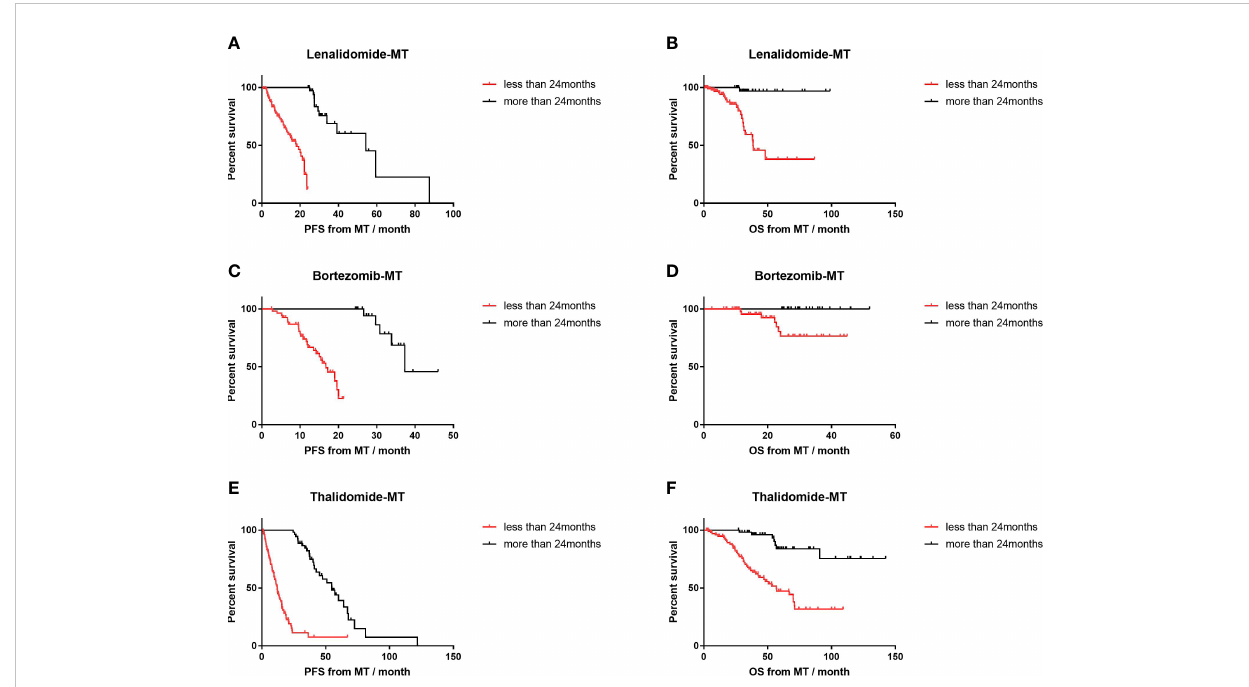
FIGURE 5 Impact of maintenance duration on progression-free survival (PFS) and overall survival (OS) of lenalidomide, bortezomib, and thalidomide maintenance. (A, B) The median PFS and median OS of patients with maintenance duration <24 months (n=103) versus those with longer maintenance (n=38) in patients on lenalidomide maintenance. (C, D) The median PFS and median OS of patients with maintenance duration <24 months (n=56) versus those with longer maintenance (n=23) in patients on bortezomib maintenance. (E, F) The median PFS and median OS of patients with maintenance duration <24 months (n=101) versus those with longer maintenance (n=54) in patients on thalidomide maintenance.